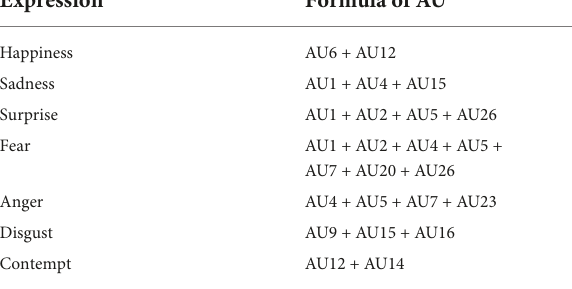
TABLE 2 Emotion